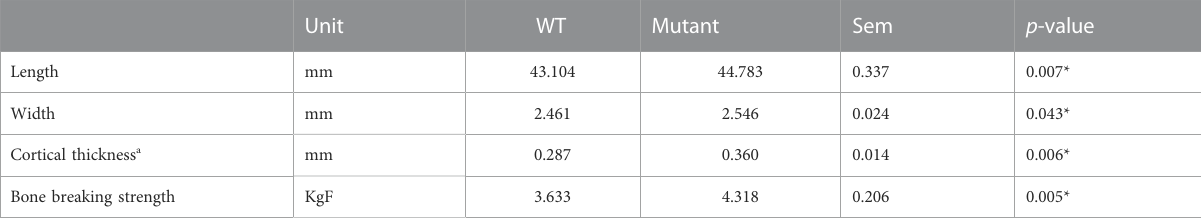
TABLE 1 Length, width, cortical bone thickness, and bone breaking strength of 4 months old WT and MSTN mutant quail tibia